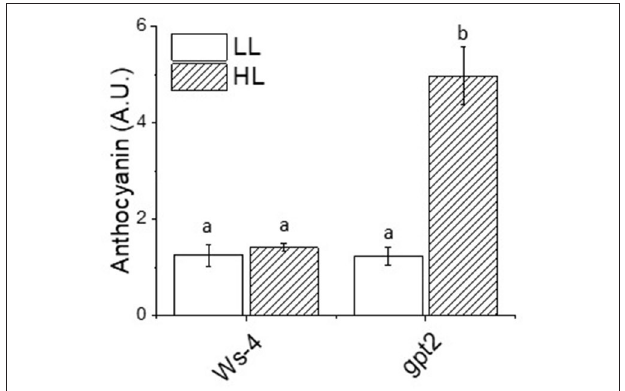
FIGURE 5 | Relative anthocyanin content of the Ws-4 wild type and gpt2 plants. Plants were grown for 7 weeks at an irradiance of under 100 µ mol m − 2 s − 1 before either remaining at that irradiance (LL) or being transferred to 400 µ mol m − 2 s − 1 (HL) conditions for 7 more days. Leaf samples were collected at the end of the photoperiod and flash-frozen prior to extraction. The data were statistically analysed using a two-way ANOVA followed by Tukey’s test at p ≤ 0.05 to be significantly different. Values represent the M ± SE of n = 5. Different letters above bars indicate significantly different